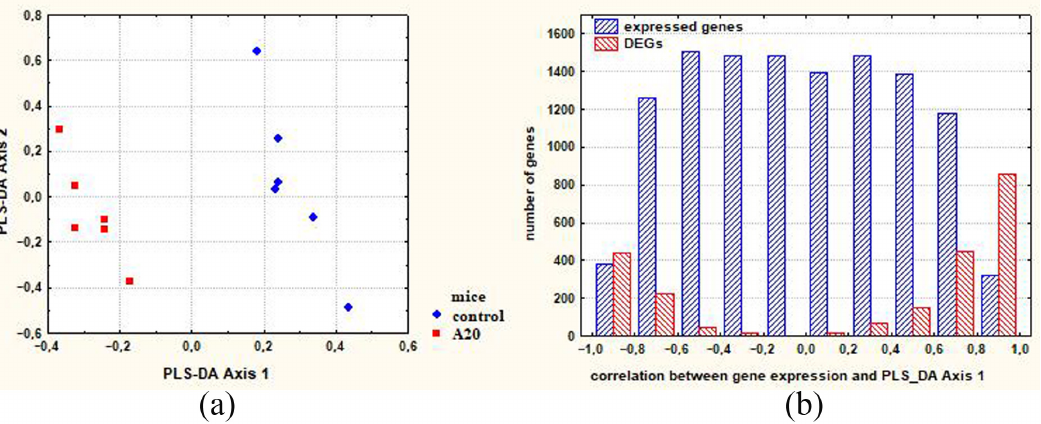
Figure 3. ( a ) Axes maximizing distances between control and A20 mice (males with consecutive 20 days of wins in daily agonistic interactions); ( b ) distribution of expressed genes along the axis representing the correlation between gene expression and PLS-DA Axis 1. DEGs: differentially expressed genes.